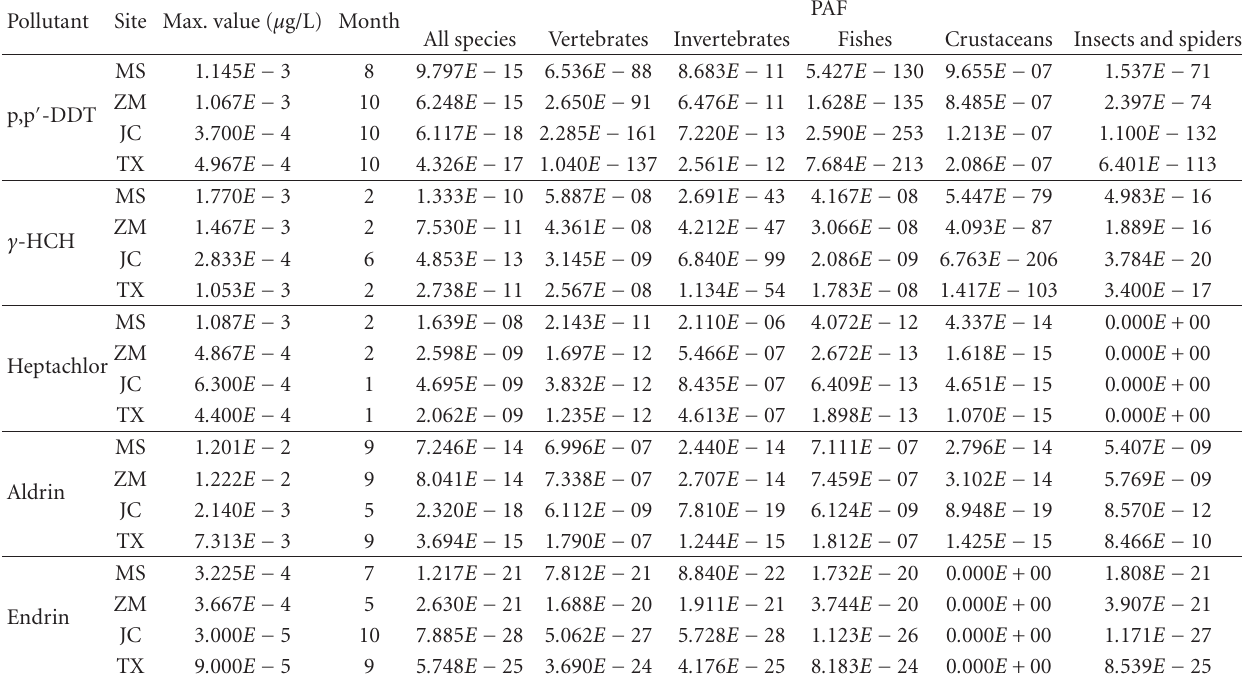
Table 7: The spatial variation of the maximum ecological risk of typical OCPs